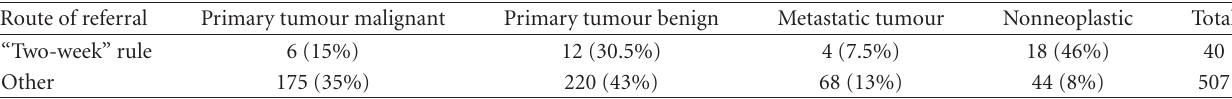
Table 1: Distribution of diagnostic categories for each referral route.